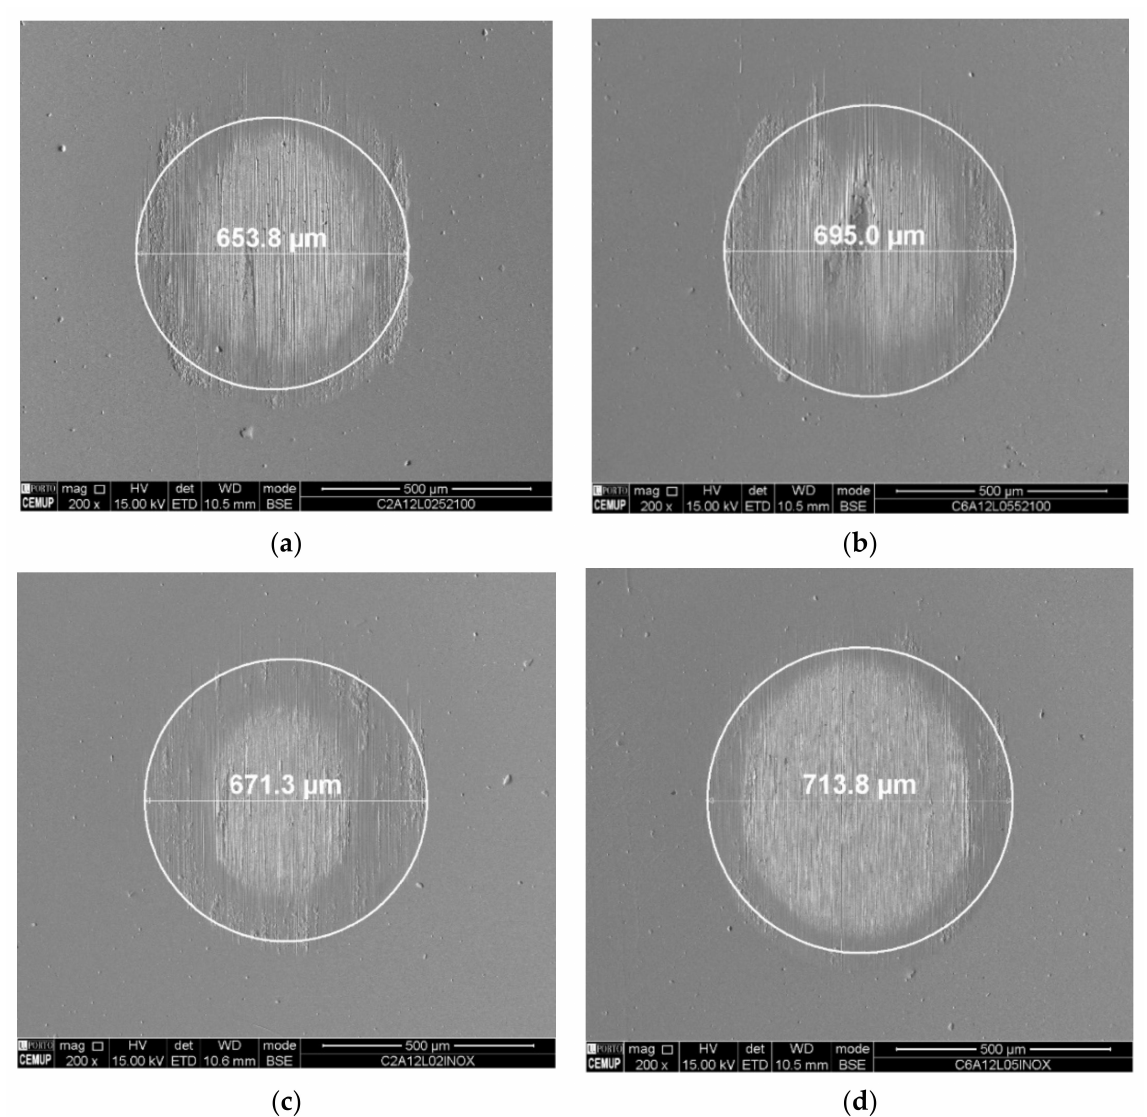
Figure 12. Wear craters generated on the test using alumina powder (1 µ m) as abrasive: ( a ) AISI 52100; load 0.2 N, ( b ) AISI 52100; load 0.5 N, ( c ) SS AISI 304; load 0.2 N, ( d ) SS AISI 304; load 0.5